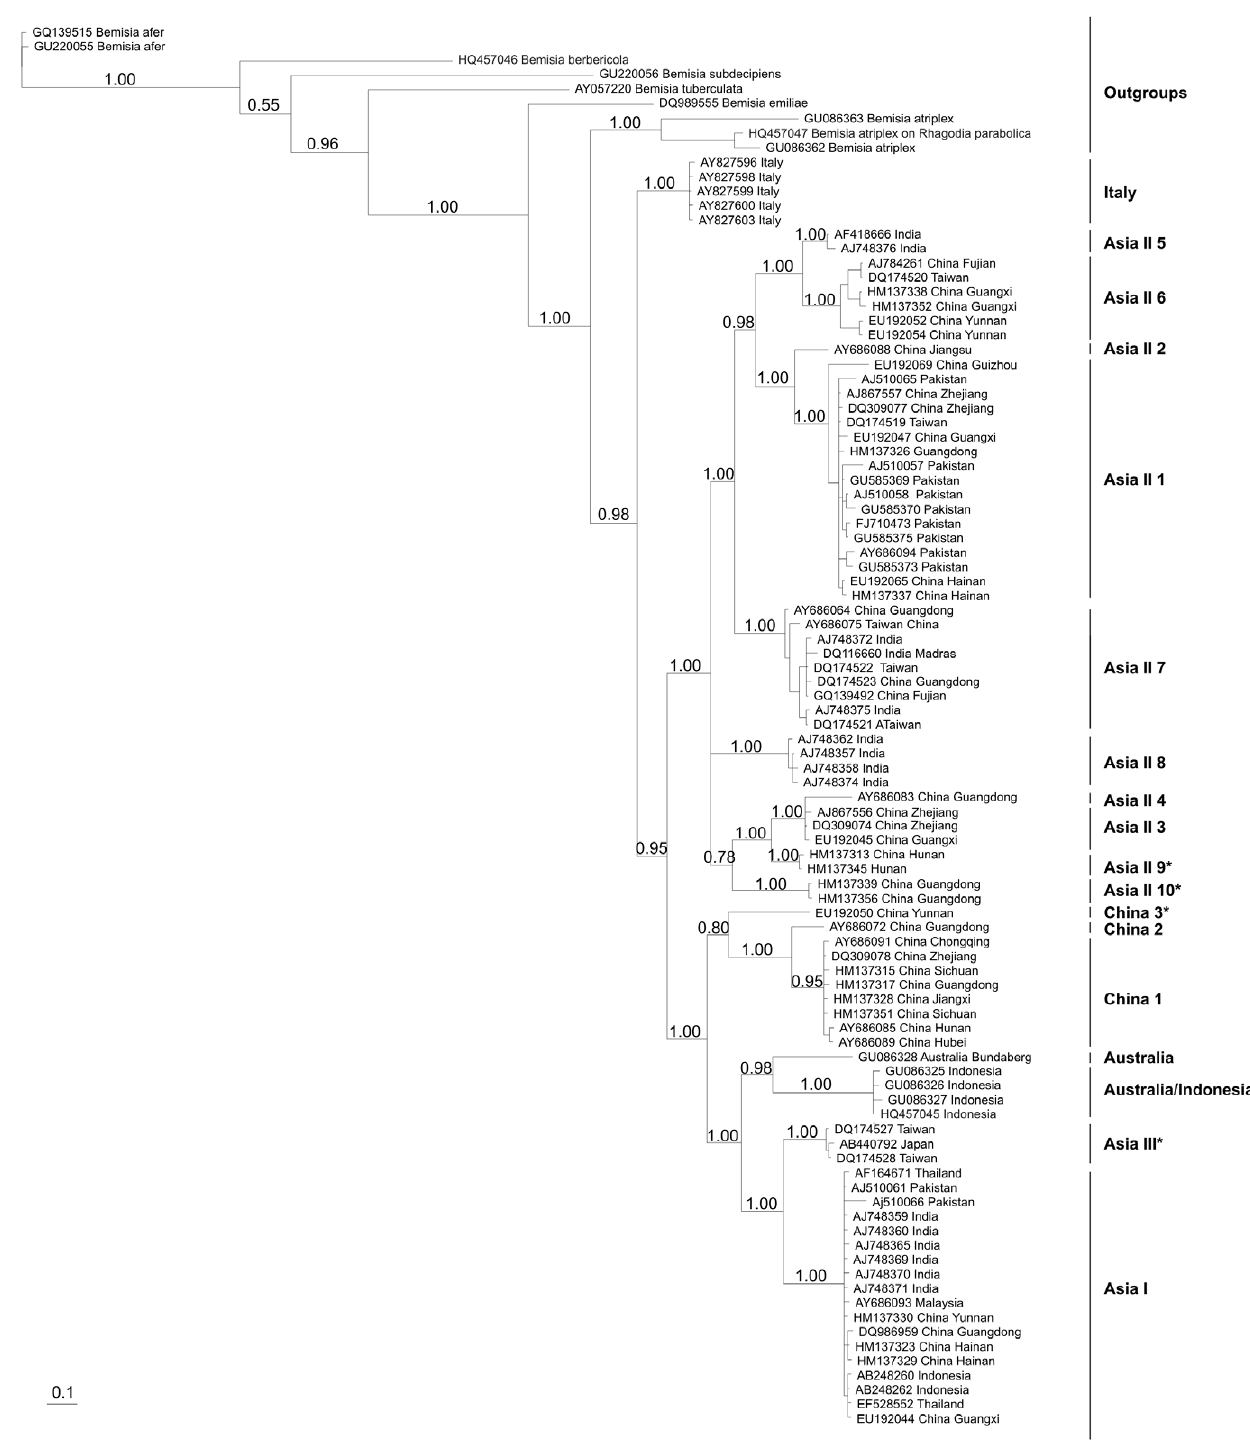
Figure 2. Phylogenetic tree based on the Bayesian analysis of mtCO1 sequences. Posterior probabilities are indicated at nodes. Species indicated by * were identified as being new species in comparison against the consensus sequences from Dinsdale et al. [10] when pairwise sequence divergence exceeded 3.5%.